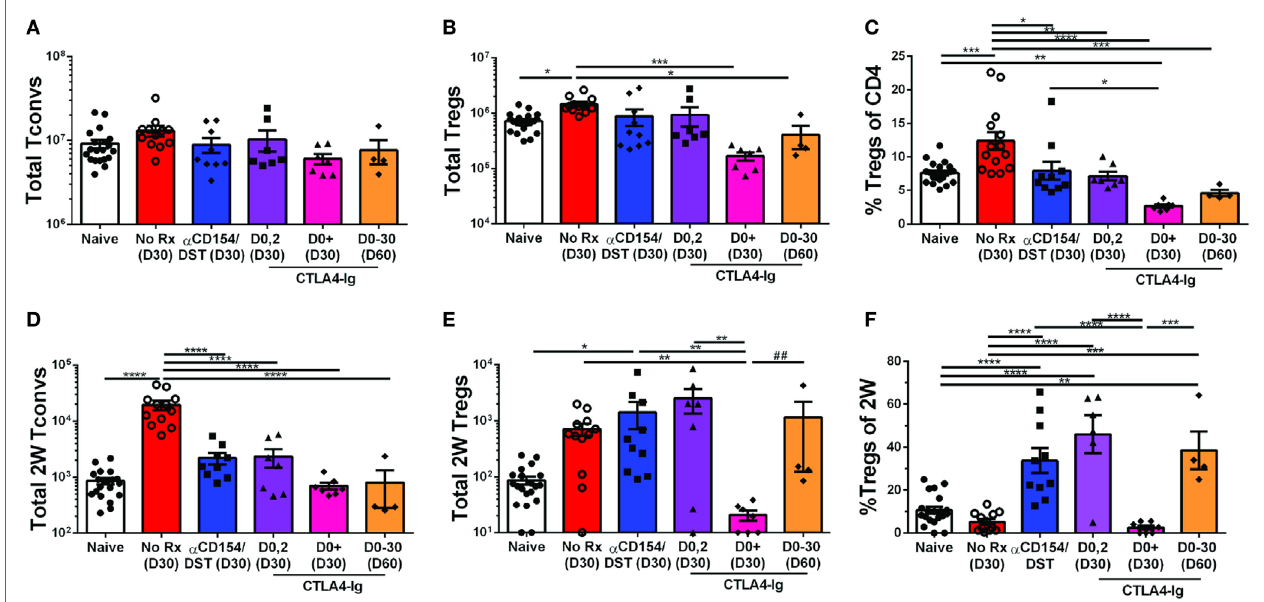
FigUre 3 | Divergent effect of transient vs. continuous CTLA4-Ig on allospecific conventional T cell (Tconv) and regulatory T cells (Tregs). C57BL/6 recipients were transplanted with heterotopic heart allografts from Act.2W-OVA + BALB/c × C57BL/6 F1 donors. Recipients were untreated (No Rx), treated with anti-CD154/DST, CTLA4-Ig on days 0 and 2 post-transplantation, or twice a week from day 0 to day 30 post-transplantation (CTLA4-Ig D0 + and D0-30) and sacrificed at either D30 or D60 post-Tx (date of sacrifice in parenthesis). Data for naïve and 30 days post-transplantation anti-CD154/DST groups are from Figures 1 and 2 . (a)